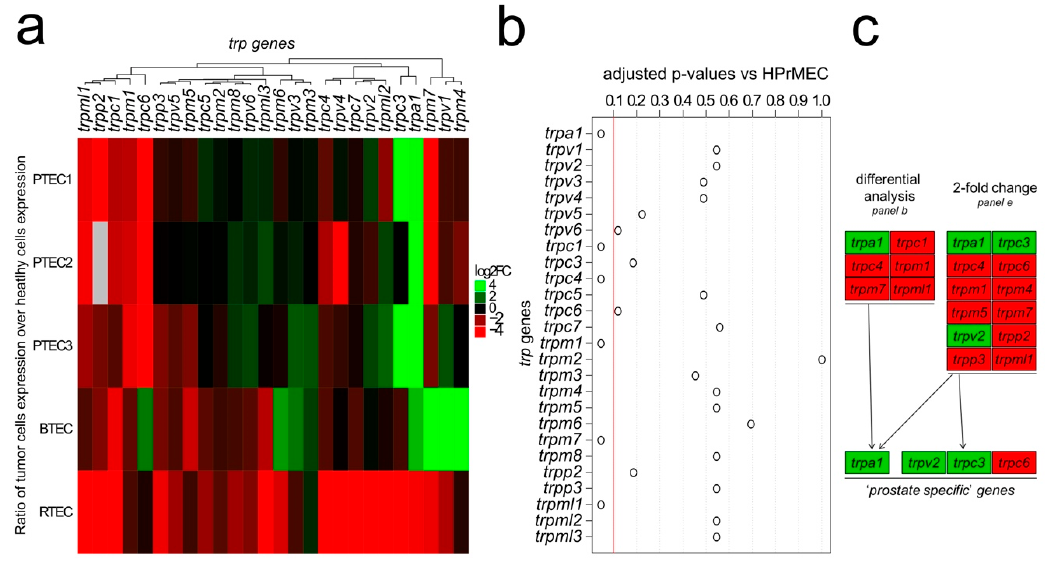
Figure 1. Figure 1. Cont.